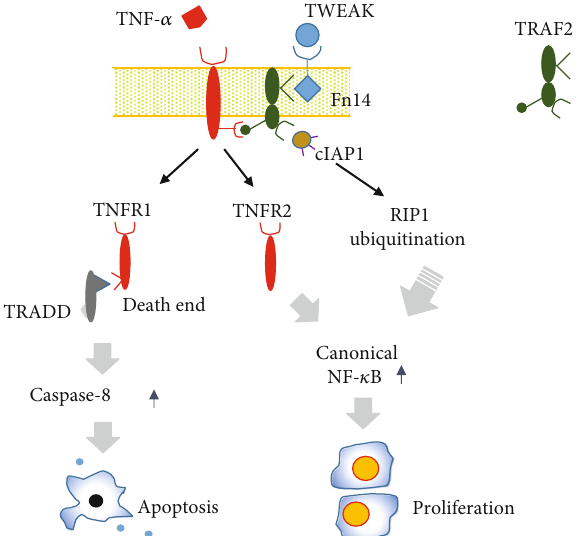
Figure 7: Diagram of the function of the Fn14-TRAF2-TNFR signaling axis. TWEAK/Fn14 interaction acts independently or cooperates with TNF- α in triggering TNFR-mediated signals. In the TNFR1-predominant cells (such as normal keratinocytes), TWEAK induces cell death through activation of the TRADD and caspase-8 pathways. Conversely, TWEAK induces proliferation of cells that overexpress TNFR2 (such as HPV-infected keratinocytes). The Fn14-TRAF2-TNFR axis is central to TWEAK ’ s regulation of cell